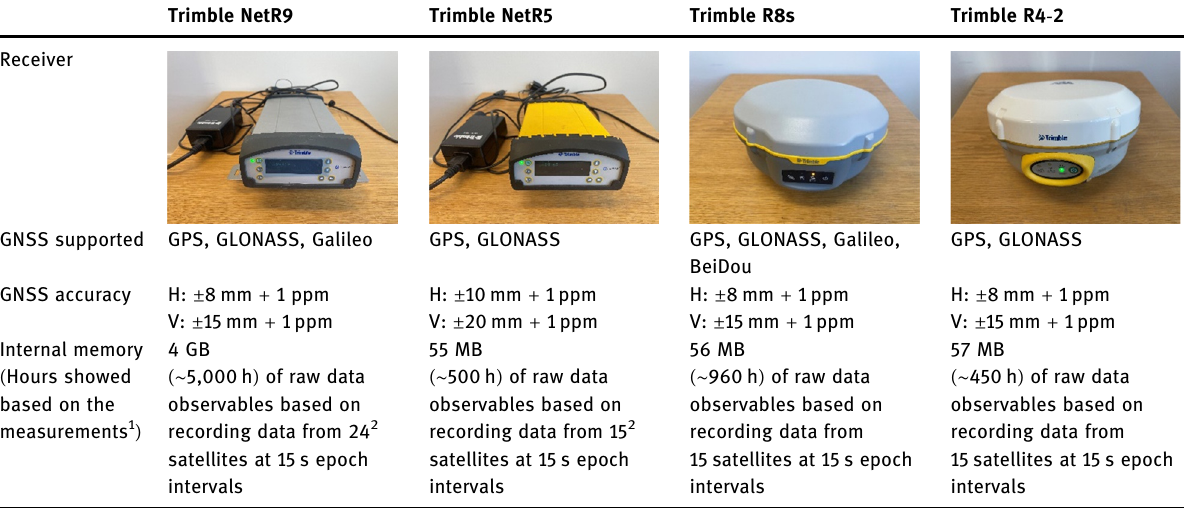
GNSS supported GPS, GLONASS, Galileo